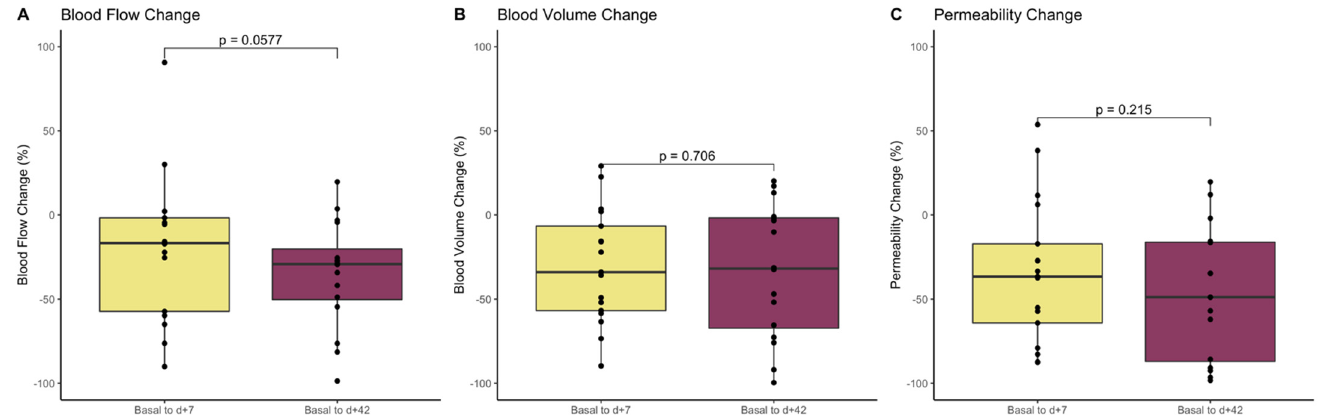
Figure 4. Boxplots showing percentage changes of blood flow ( A ), blood volume ( B ), and permeability ( C ) at day +7, and day +42 after treatment initiation compared to basal values in the entire population.